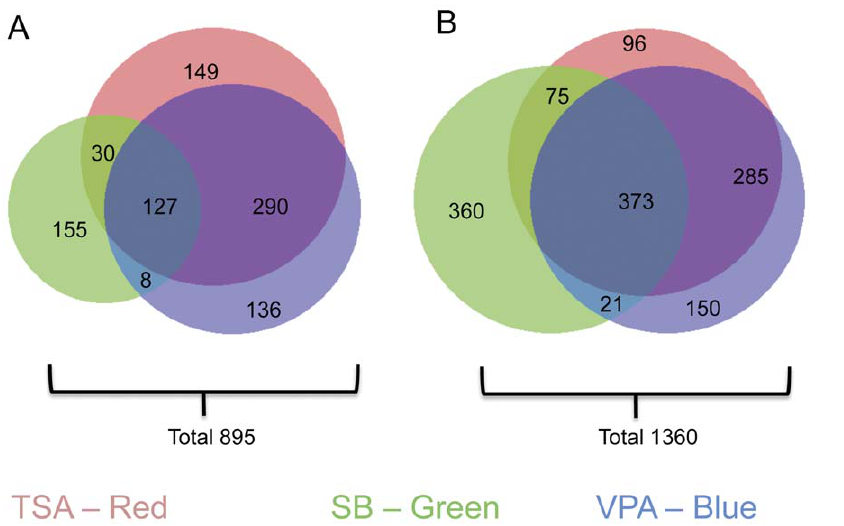
Figure 2. Venn analysis of gene expression changes associated with HDACi treatment of differentiated midbrain cultures. Differentiated midbrain cultures were treated with 330 nM TSA, 50 mM SB or 50 mM VPA respectively for 48 hours and gene expression was analyzed using Agilent whole mouse genome expression microarray chips. Genes with a p-value of , 0.02 were considered differentially expressed (DEGs) and subjected to Venn analysis. (A) A total of 895 genes are up-regulated by HDACi treatment. A subset of 127 of these genes are up- regulated by all three drug. (B) A total of 1360 genes are down-regulated as a result of HDACi treatment, with a subset of 373 genes being down- regulated by all three drugs. Numbers represent the total number of modulated genes in that experimental condition.